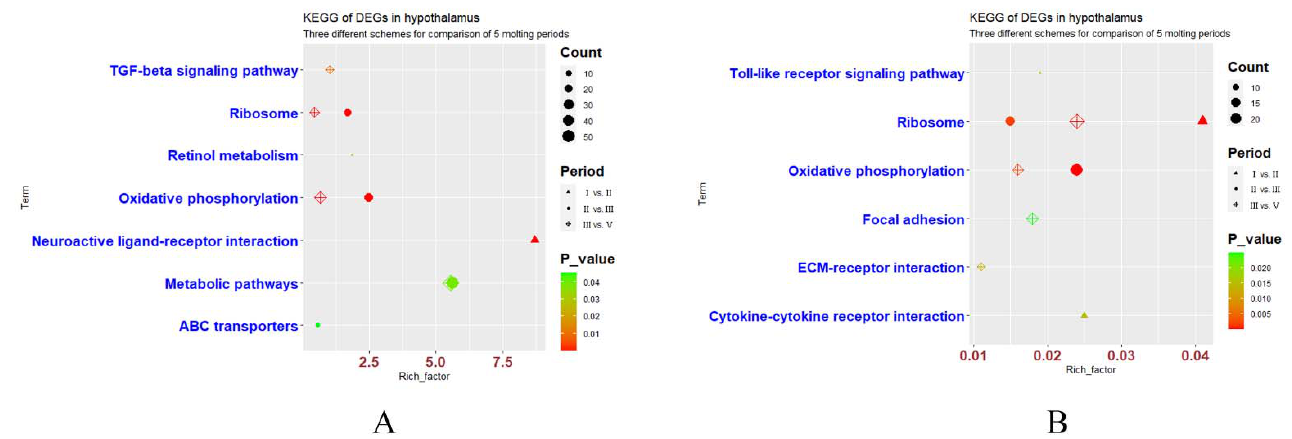
Figure 3. The KEGG pathways of three groups of DEGs in hypothalamus and ovary during FM. Significant KEGG pathways of DEGs ( p < 0.05) from the comparison of I vs. II, II vs. III, and III vs. V in the hypothalamus ( A ) and ovary ( B ).